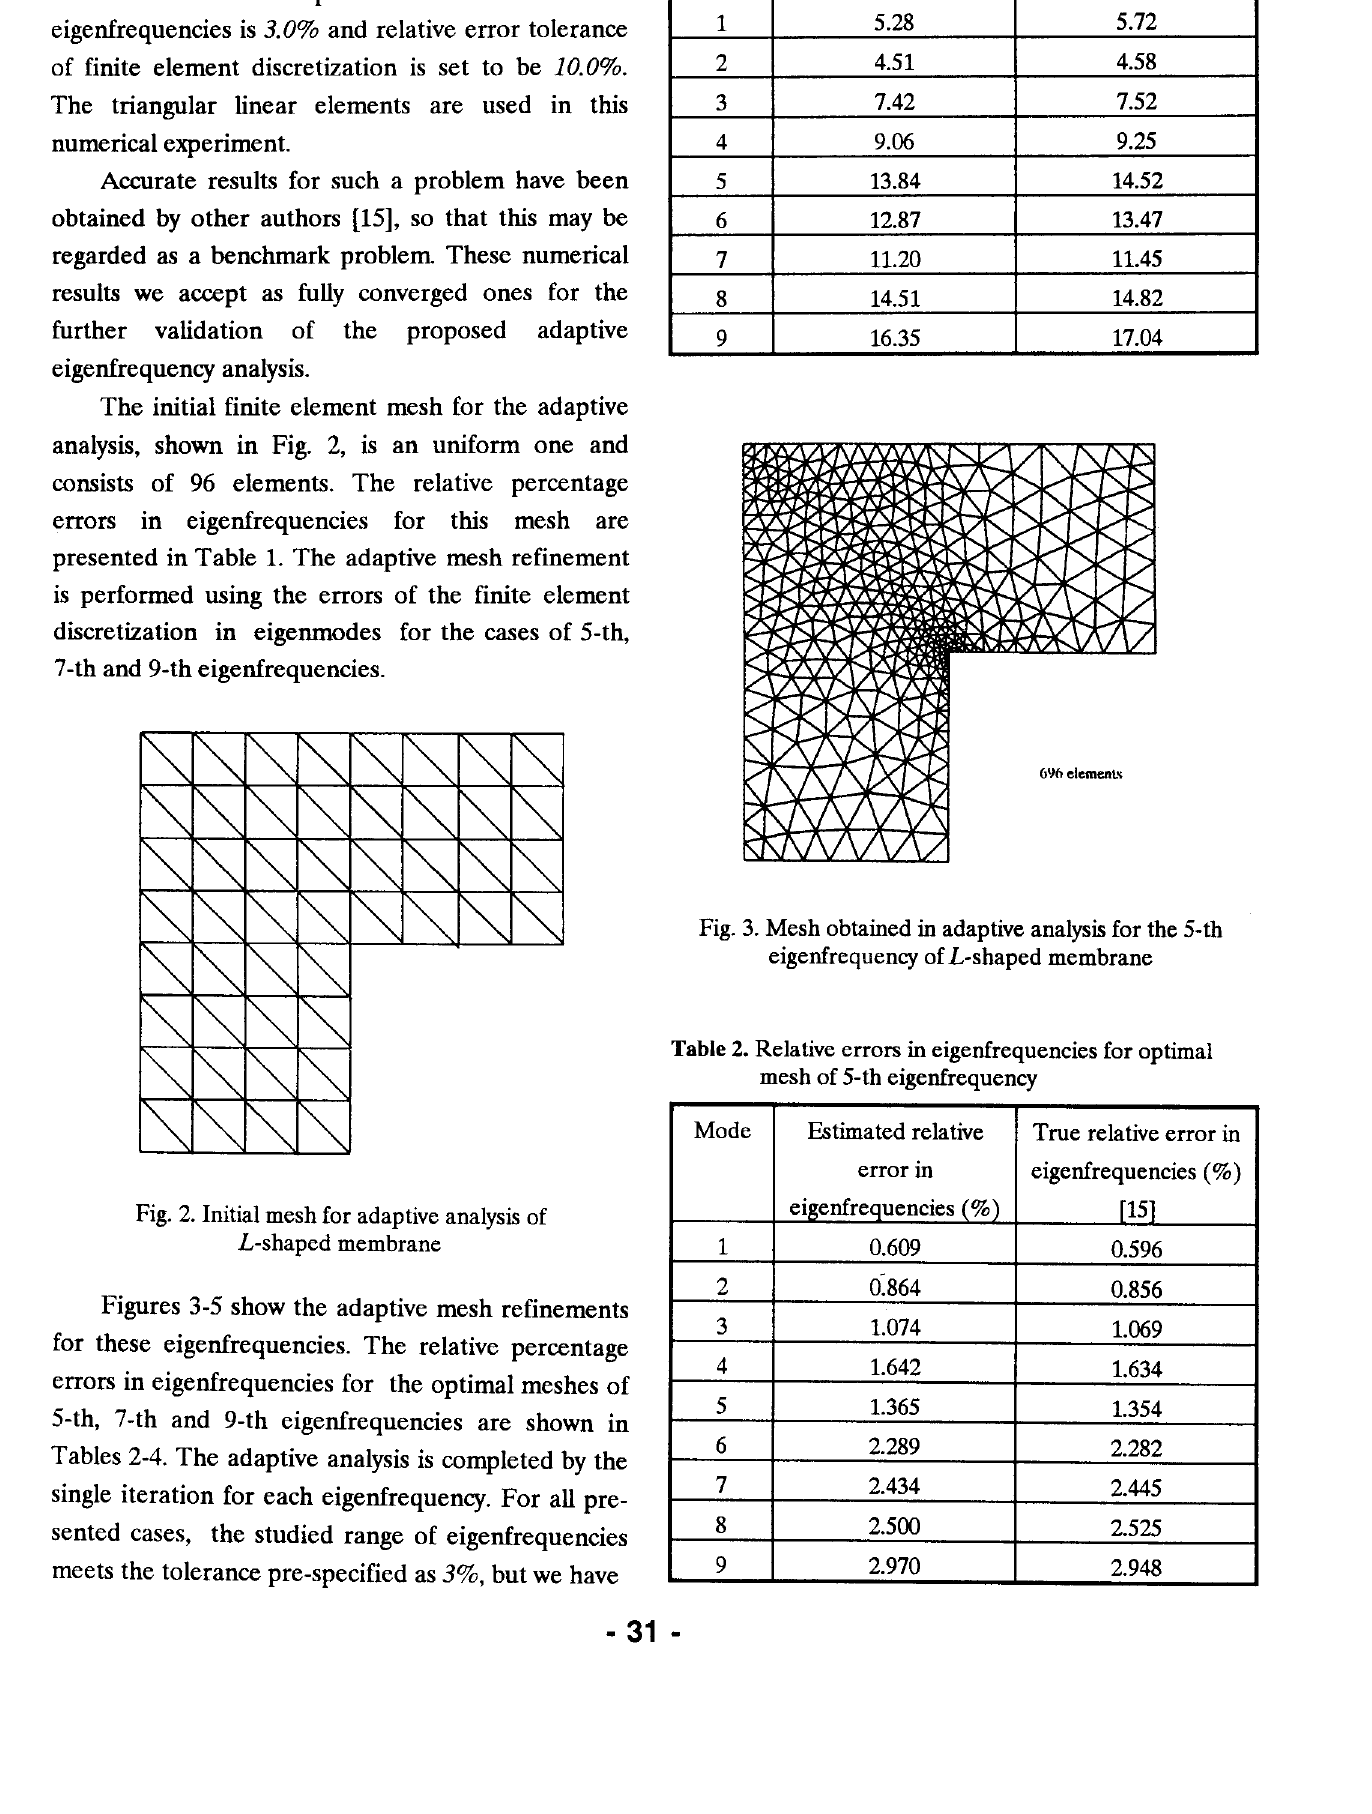
Table 1. Relative errors in eigenfrequencies for initial mesh